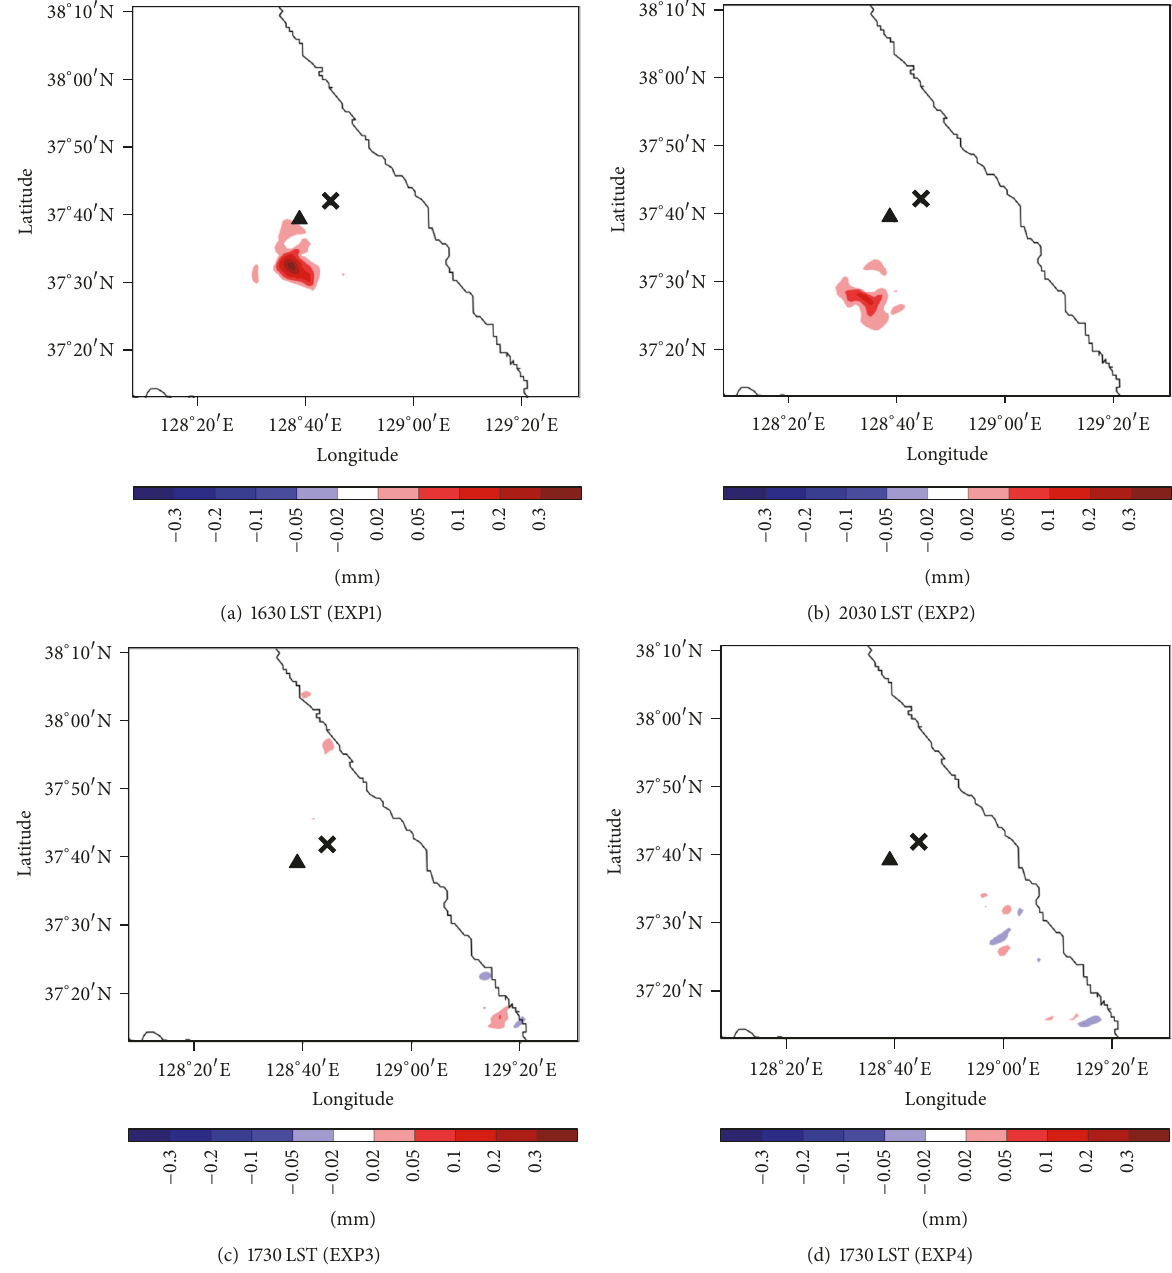
Figure 7: Differences between the accumulated seeded and nonseeded precipitation (mm) during the period from the start of seeding to the end of post-SEED. The triangle and cross indicate the locations of YP and CPOS,